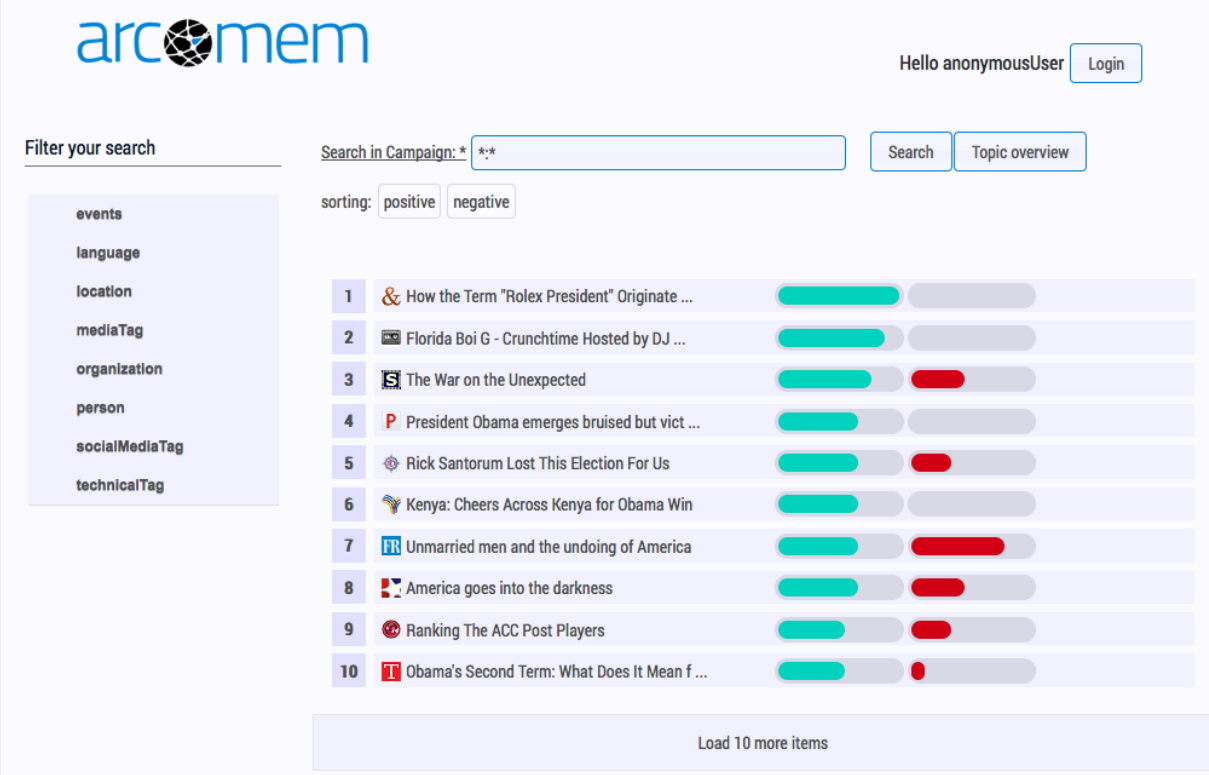
Figure 3. In the web resource view, the user may examine the